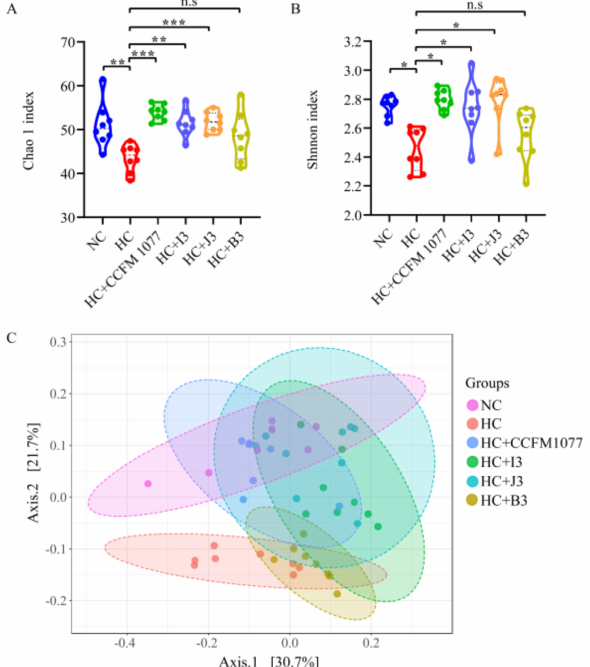
Figure 5. Effects of four B. longum strains (CCFM 1077, I3, J3, B3) on the overall structure of fecal microbiota. Alpha diversity was represented by ( A ) Chao 1 index and ( B ) Shannon index. Beta diversity was represented by ( C ) PCoA, based on weighted UniFrac distances. *** represents p < 0.001, ** represents p < 0.01, * represents p < 0.05, n.s represent non-significant with p > 0.05. Through MiSeq sequencing analysis, we obtained 1,780,569 high-quality, classifiable 16S rRNA gene sequences in 36 fecal samples. The average sequence read was 12,864 bp